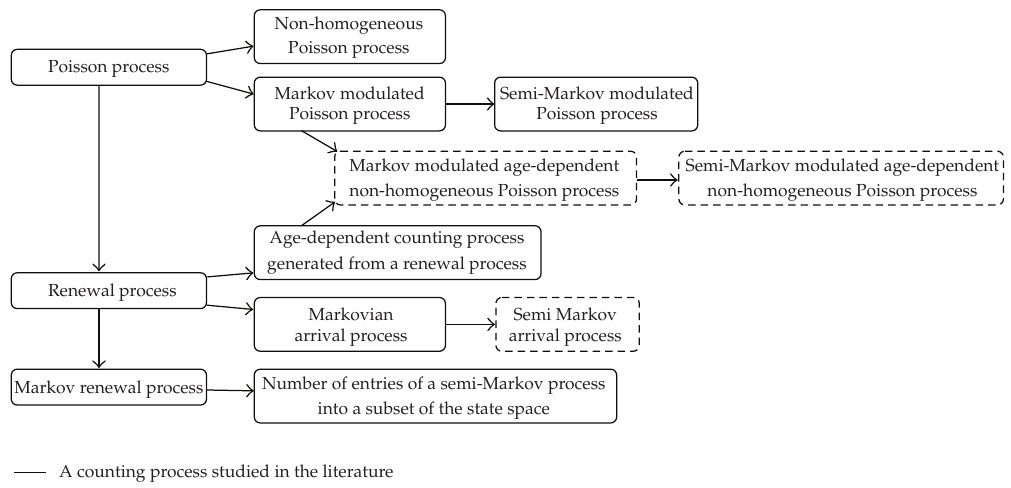
Figure 1: Various counting